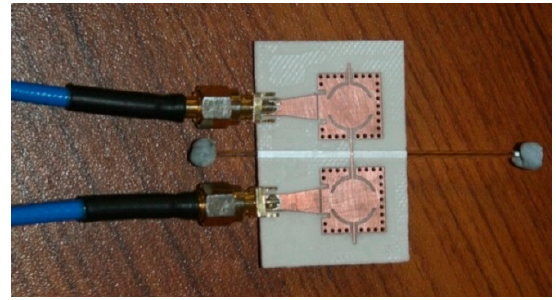
Figure 4. The vertical placement of the LUT on the SIW filter.